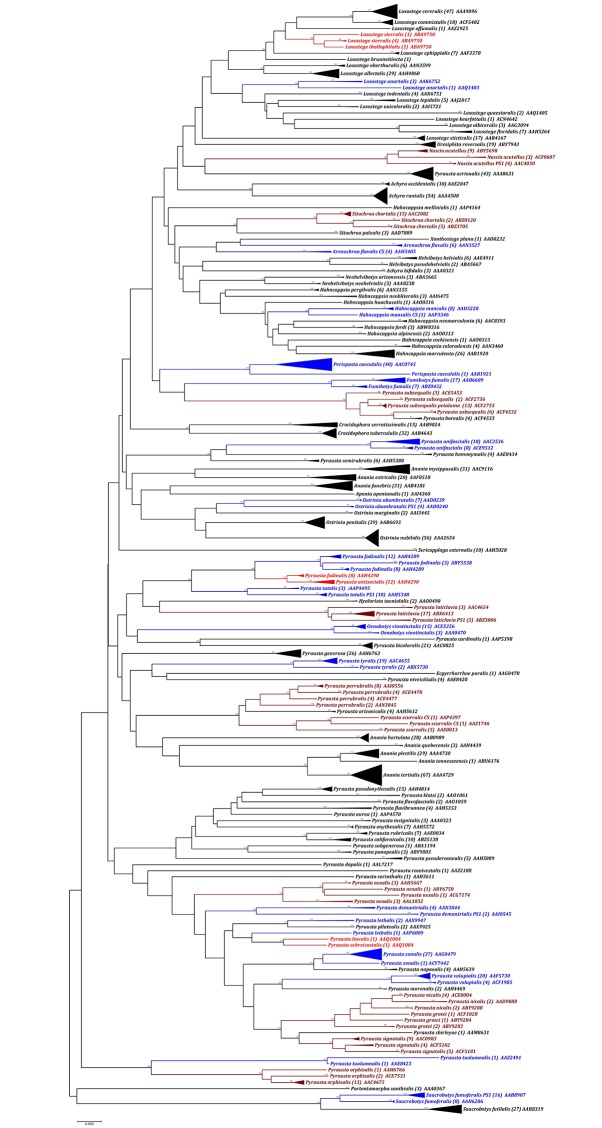
Neighbor-Joining tree (K2P) for 1379 COI sequences from Pyraustinae.The depth of each branch shows the divergence within each species. Numbers above branches indicate bootstrap values (>75 shown). Numerals in parenthesis following a species name indicate the number of individuals analyzed. Three letters followed by four numbers indicate the BIN. Taxa sharing a BIN are highlighted in light red, while paraphyletic and polyphyletic taxa are shown in blue and dark red respectively.